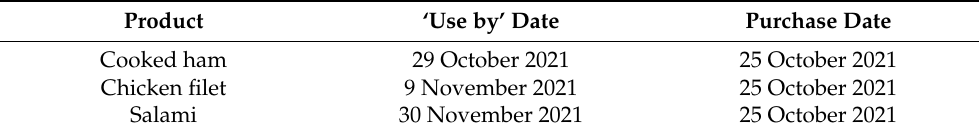
Table 3. Characteristics of commercial meat products used for testing inhibition of background microbiota by selective medium for Em-resistant C. botulinum strains.